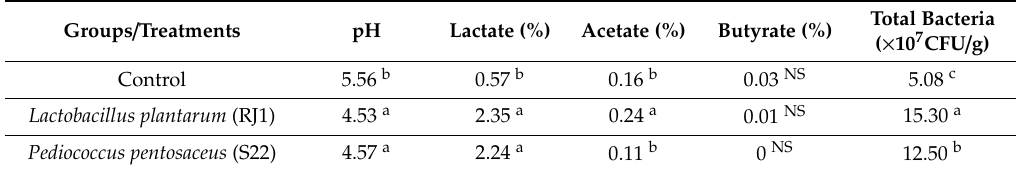
Table 3. Analysis of pH, microbial population, and organic acid concentrations of high-moisture LAB ( L. plantarum RJ1 and P. pentosaceus S22)-inoculated and non-inoculated alfalfa silage on day 180 of incubation. Data represent mean values ± SD ( n = 3), and superscript letters (a, b, c) within the same column are significantly di ff erent at p < 0.05. NS: not significant at p < 0.05.